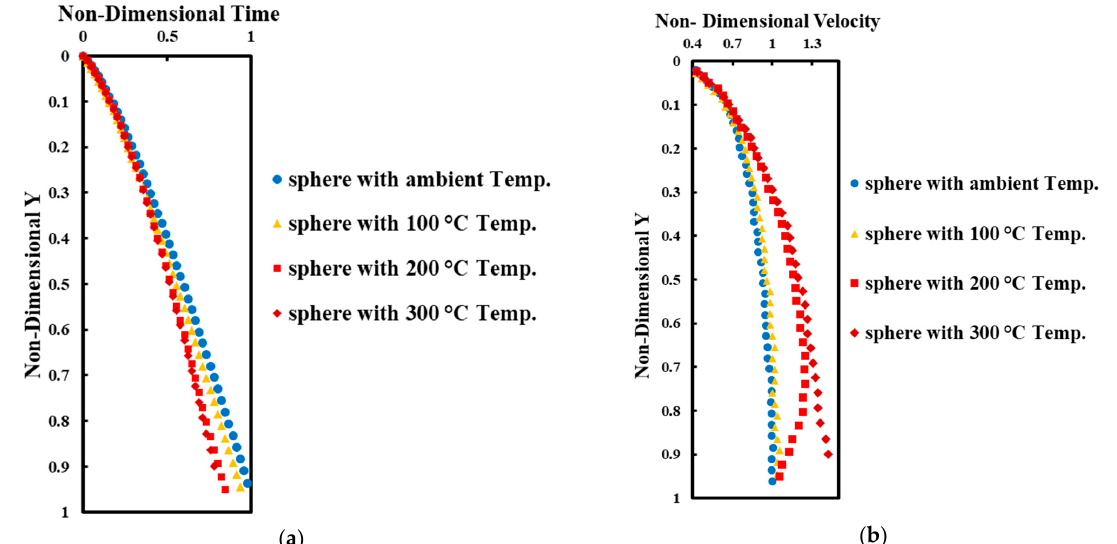
Figure 4. Vertical location of the sphere: ( a ) in terms of dimensionless time and ( b ) in terms of dimensionless velocity of the sphere at different temperatures (non-dimensional Y = y / L where L is length of channel and non-dimensional time = t / T where T is the time the sphere’s velocity reaches its terminal velocity).